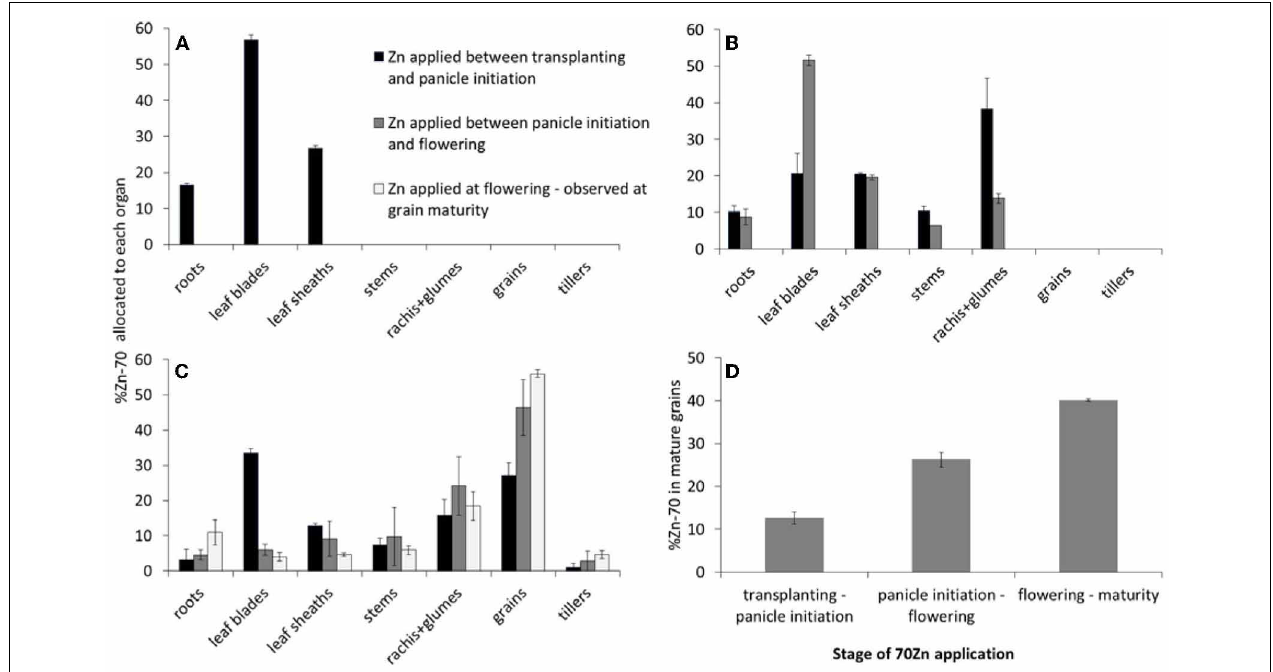
FIGURE 2 | Allocation of 70 Zn as observed by destructive sampling at 1 week after panicle initiation (A), at flowering (B), and at grain maturity (C), and as influenced by the period during which the plants received the 70 Zn (D) (Experiment 2). Panel (D) shows